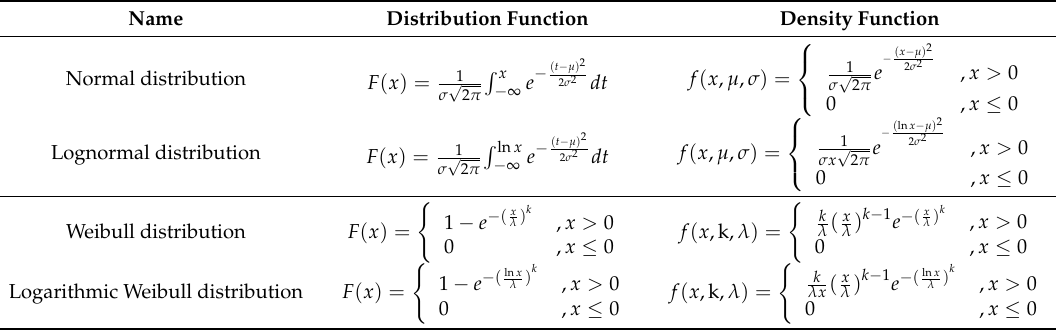
Table 1 is the equation for the distribution function and density function of the four distributions. Table 1. Distribution functions and density functions of the four